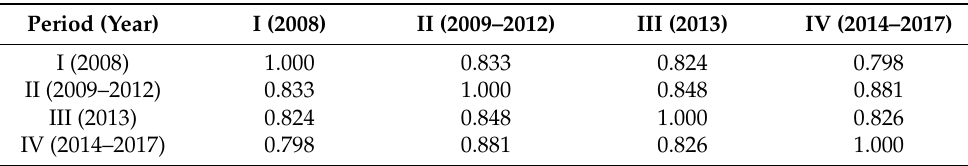
Table 5. Correlation of four periods of geohazard susceptibility.